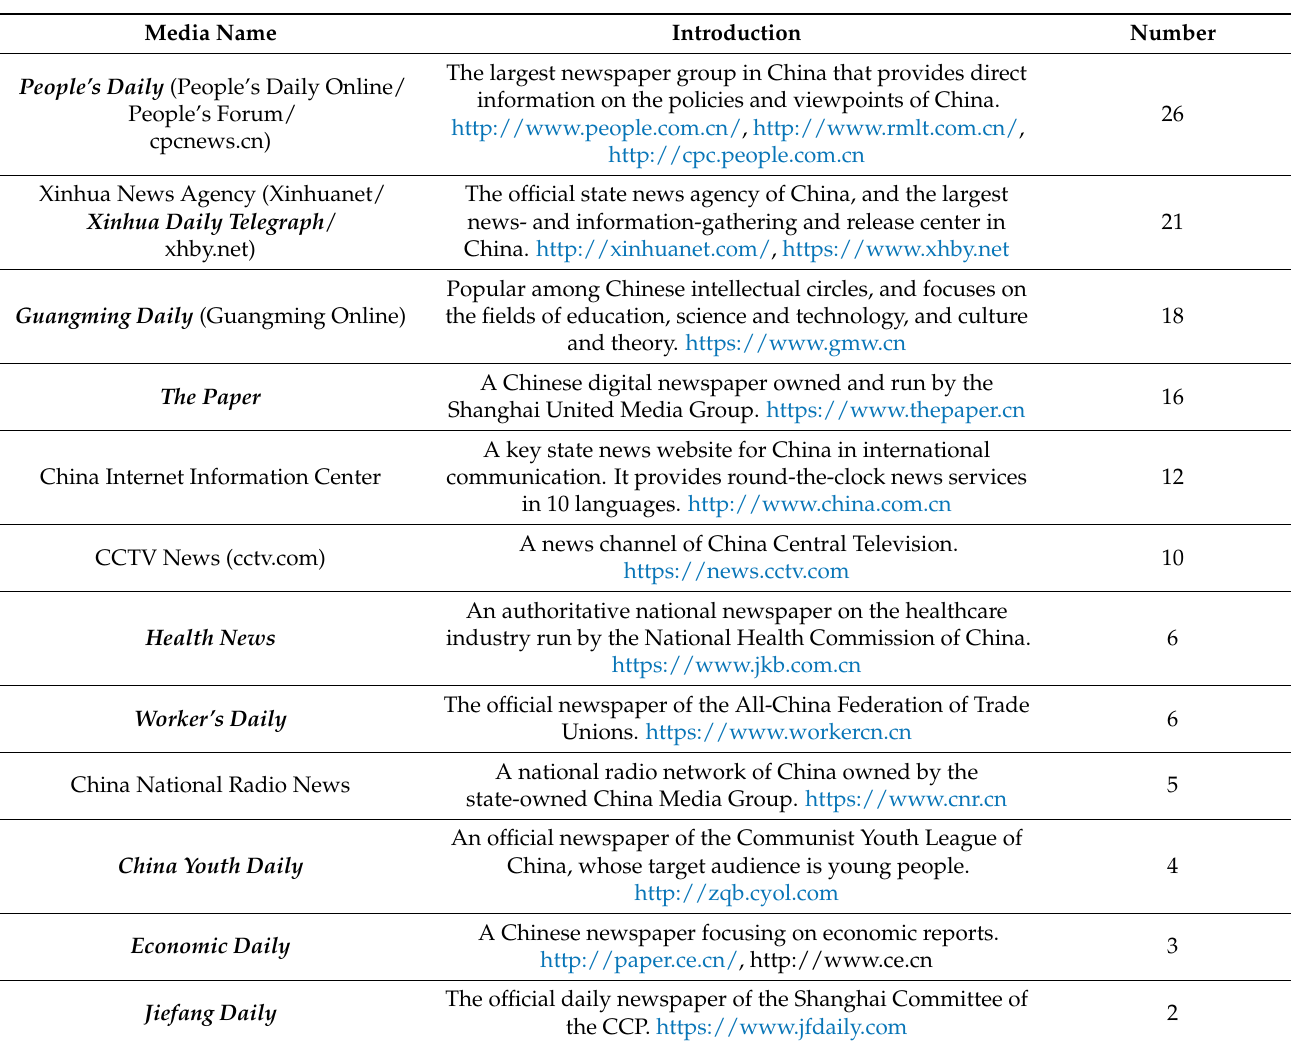
Table 1. List of news agencies and